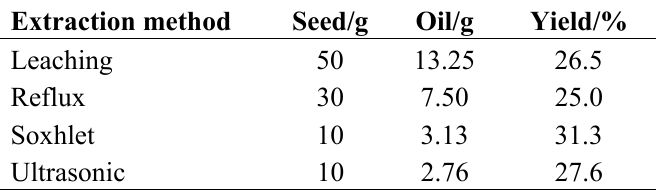
Table 1. Comparison of four extraction methods in preparing Pistacia chinensis seed